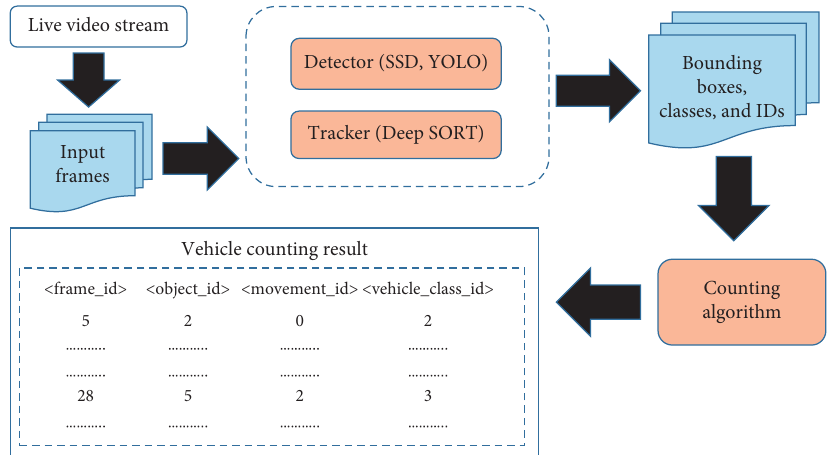
Figure 2: The block diagram depicts the data flow in the proposed system. The video input goes through detector and tracker components to create bounding boxes and identification before counting by our counting